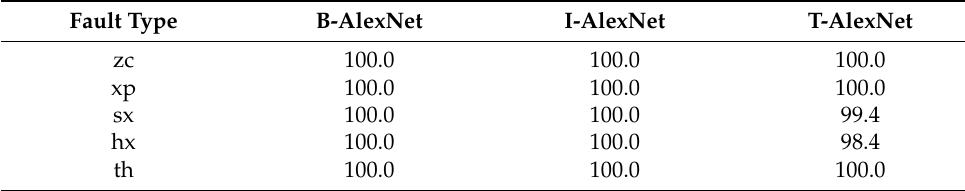
Figure 27. Confusion matrix of a trial. ( a ) B-AlexNet, ( b ) I-AlexNet, ( c ) T-AlexNet. Table 7. Precision of each condition with different models.